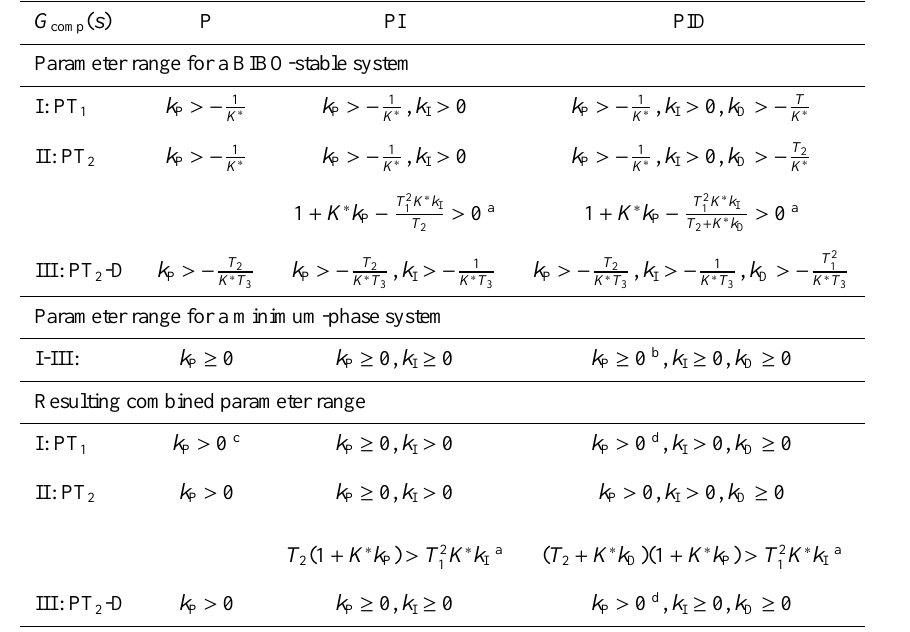
Table 5. Parameter range guaranteeing BIBO-stability and a minimum-phase system, and the resulting combined parameter range satisfying both requirements for all considered sensor-controller combinations.